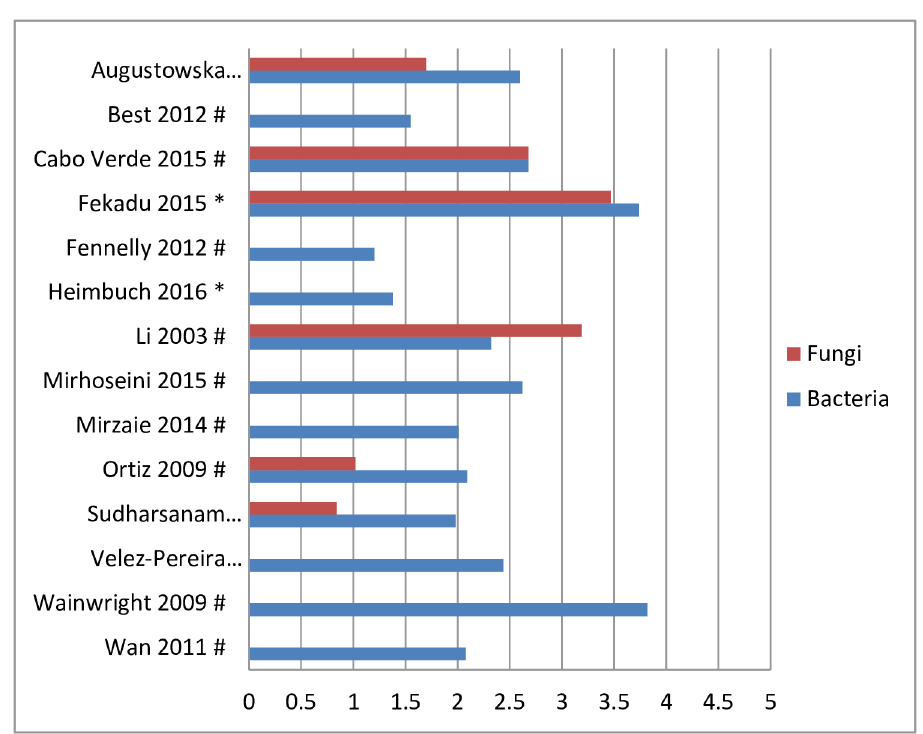
Fig 2. Bacterial or fungal loads in mean Log-10 CFU/m 3 in hospitals. * = passive samplingmethod; # active samplingmethod.